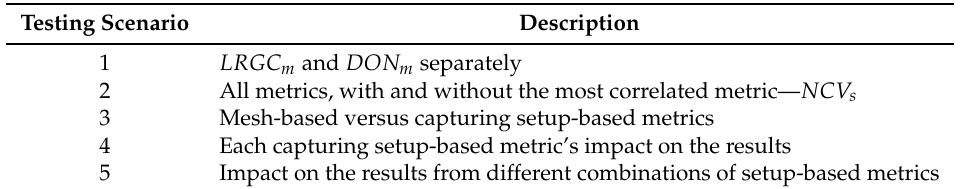
Table 4. The four main subset test scenarios. Each of the scenarios is designed to test the impact of different metrics or combination of metrics on the final results.